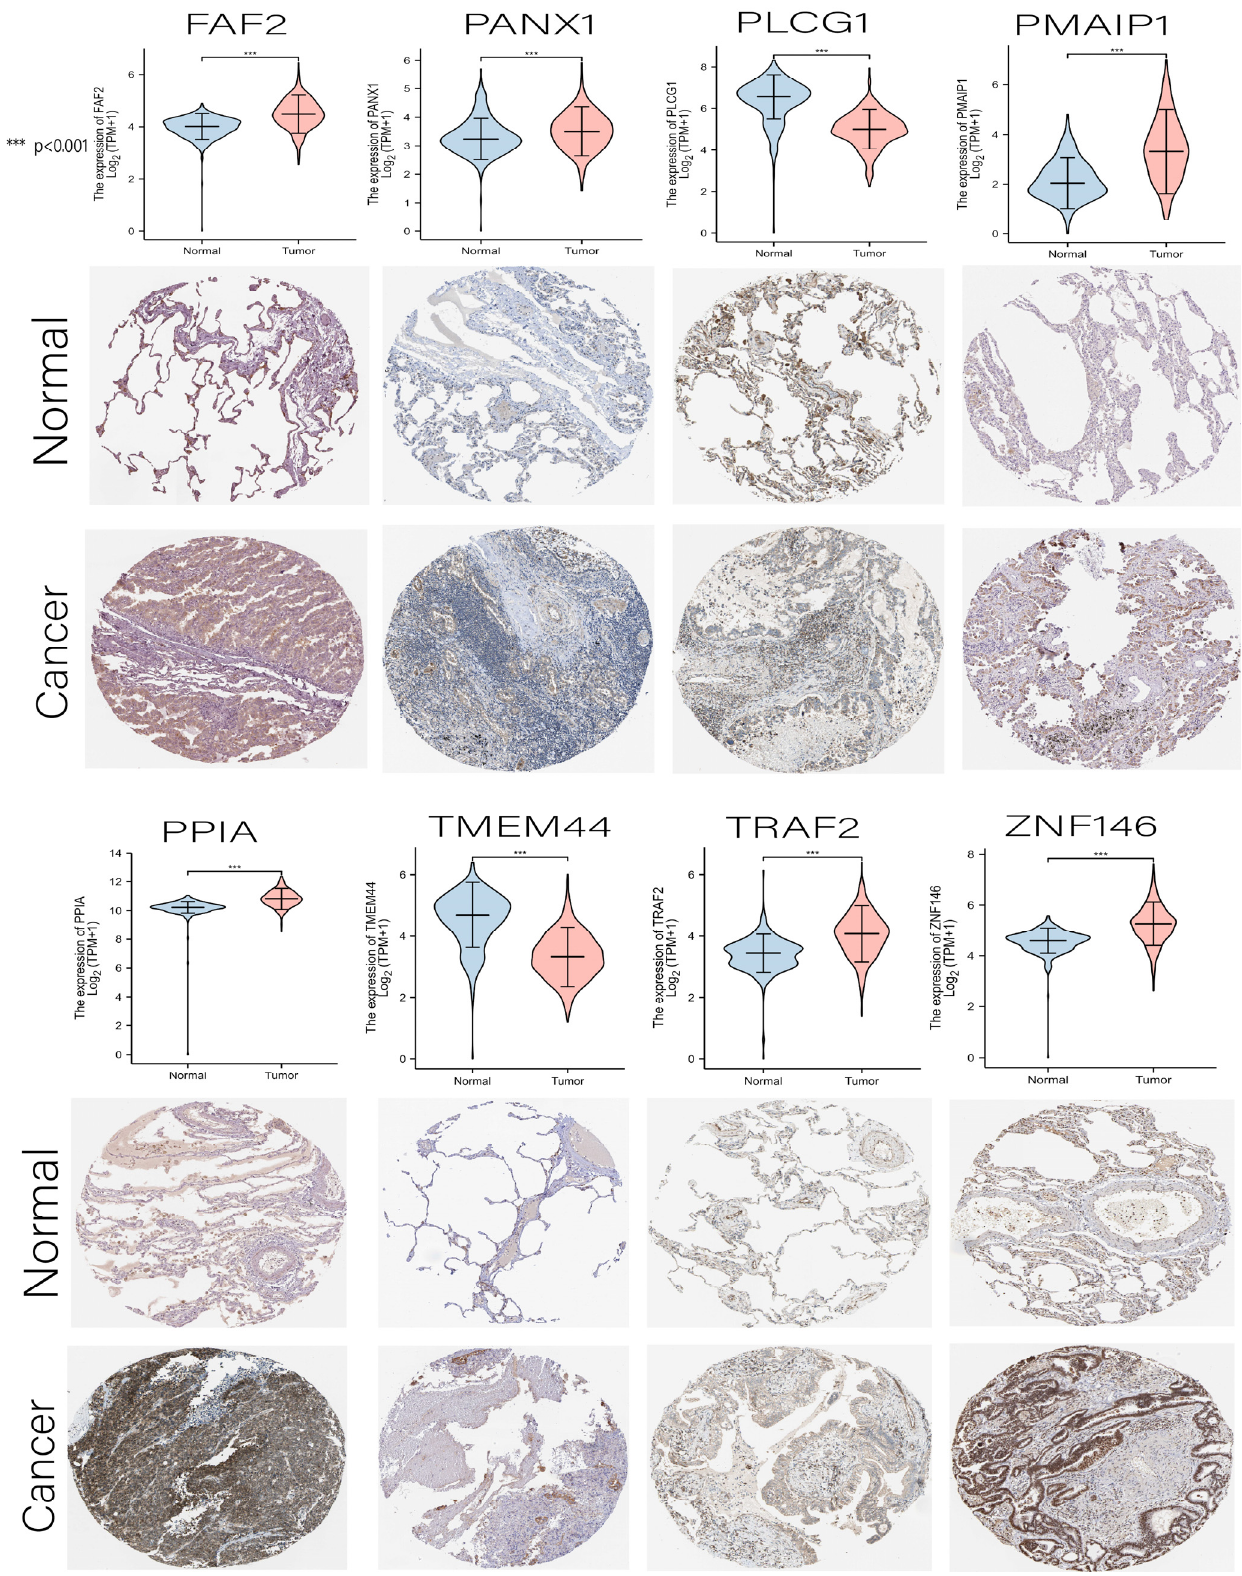
Figure 11. Differential expression map and immunohistochemical results of nine DENRGs in the prognostic model (MLKL is not available in the HPA database). *** p < 0.001.